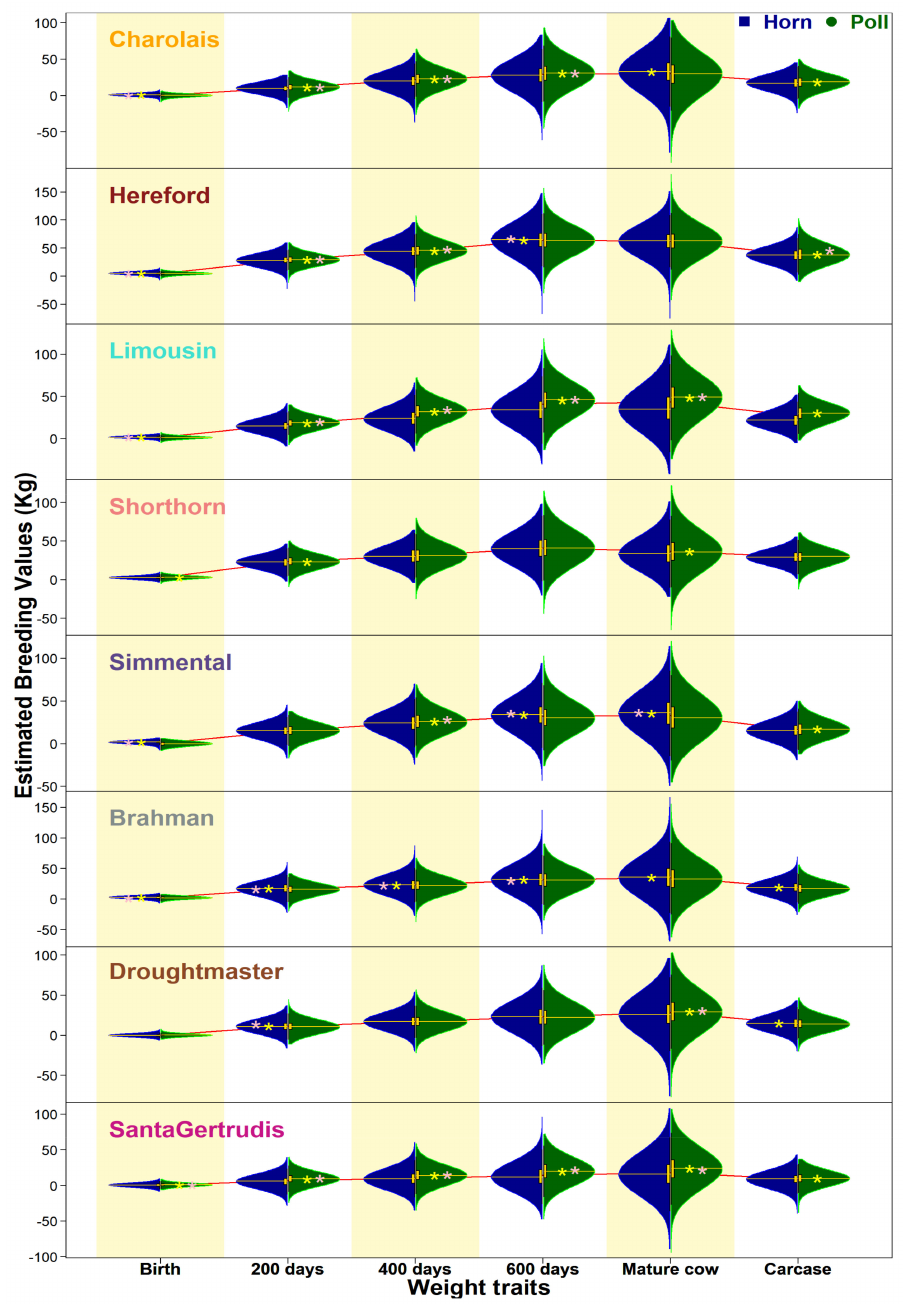
Figure 6. Violin plots of BREEDPLAN EBVs (accuracy ≥ 50%) of weight traits at different life stages in eight breeds comparing horn and poll cohorts born 2000–2018. Yellow and pink steric represent a statistically significant higher cohort-mean at 50% and 70% accuracies of EBVs,